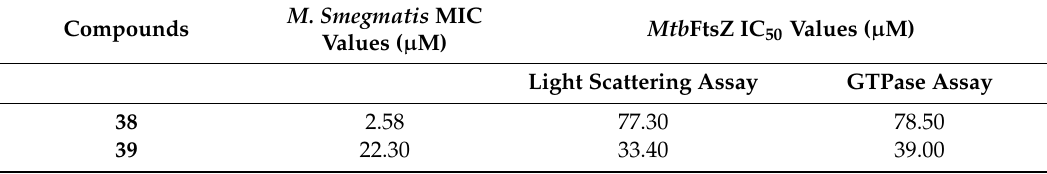
Figure 7. Chemical structures of bedaquiline ( 37 ) and 1,2-dihydroquinolines 38 and 39 . Table 5. Biological evaluation of 1,2-dihydroquinolines analogues 38 and 39 .